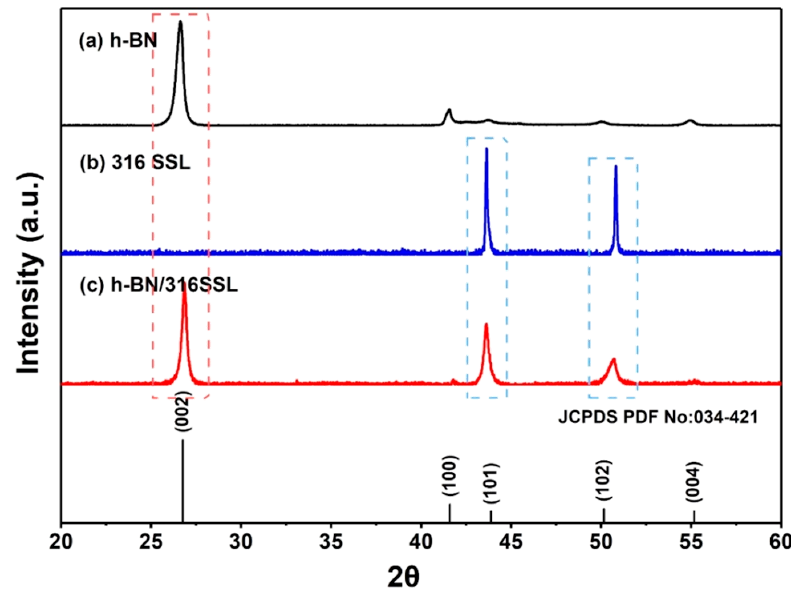
Figure 4. XRD patterns of ( a ) pure h-BN particles, ( b ) SS316L, ( c ) coating prepared by EPD using 30 V and 10 min.